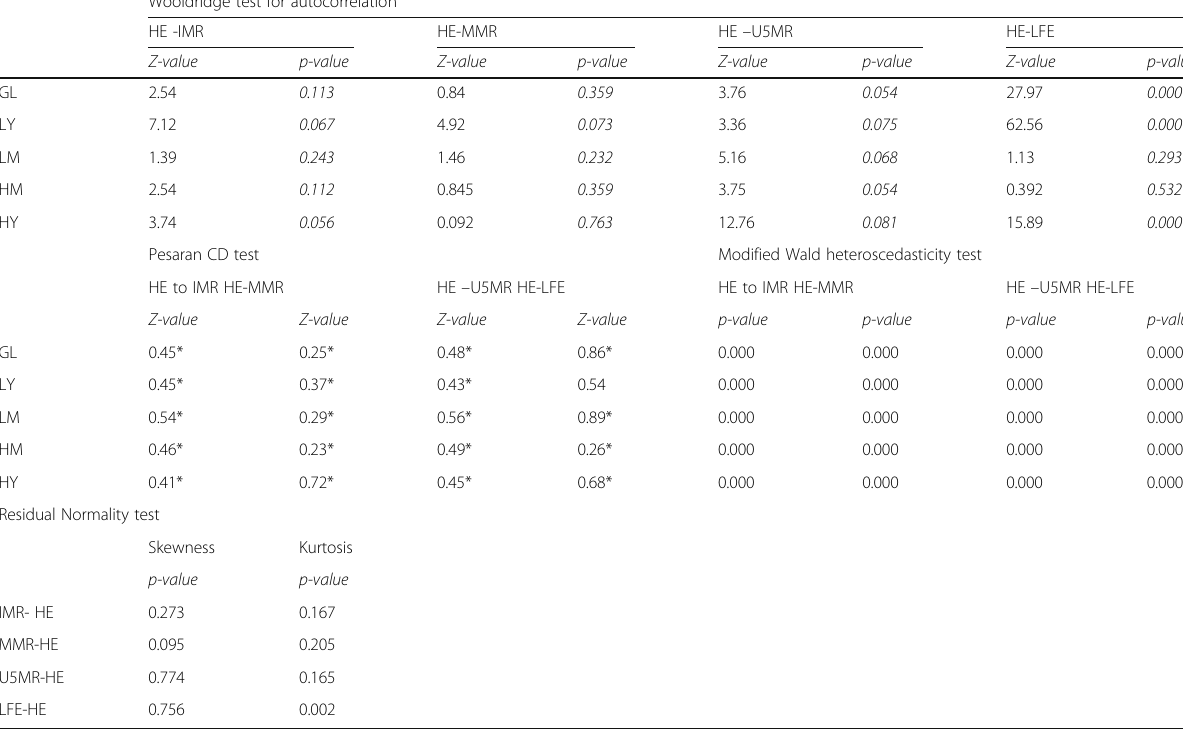
Table 6 Key diagnostic tests Wooldridge test for autocorrelation